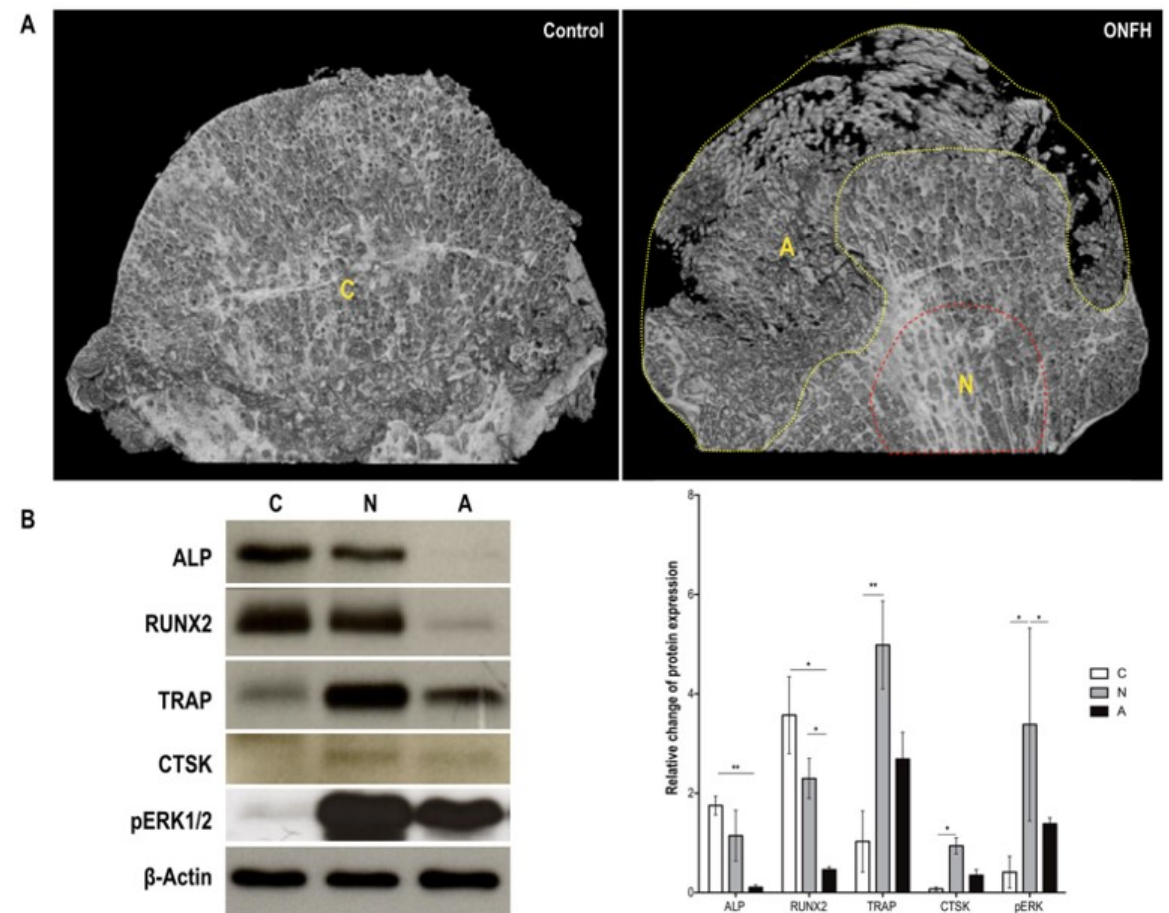
Figure 7. Expressions of osteoblast and osteoclast markers in the bone tissues of patients with ONFH. ( A ) Frontal section of µ CT images of the femoral heads of patients in control and experimental (ONFH) groups. Letters indicate different tissue regions, namely, regions with normal bone (labeled as C) as well as non-necrotic (labeled as N) and necrotic (labeled as A) ONFH tissues for protein extraction. ( B ) Expression and quantification of osteoblast and osteoclast markers in the control and ONFH tissues. After proteins were extracted from the C, N (encompassed by the dashed red line near the femoral neck), and A (encompassed by the dashed yellow line) regions, osteoblast (ALP and RUNX2) and osteoclast (TRAP and CTSK) markers were used to detect the protein levels in the three regions. The density of the four bands was normalized to that of the internal control, β -actin. Each bar corresponds to a single group and represents the mean ± SD (control, n = 7; ONFH, n = 7). Asterisks at the tops of bars indicate significant differences (* p < 0.05 and ** p < 0.01) between groups. Abbreviations: A, avascular necrotic; ALP, alkaline phosphatase; CTSK, cathepsin K; ONFH, osteonecrosis of the femoral head; µ CT, micro-computed tomography; RUNX2, runt-related transcription factor 2; TRAP, tartrate-resistant acid